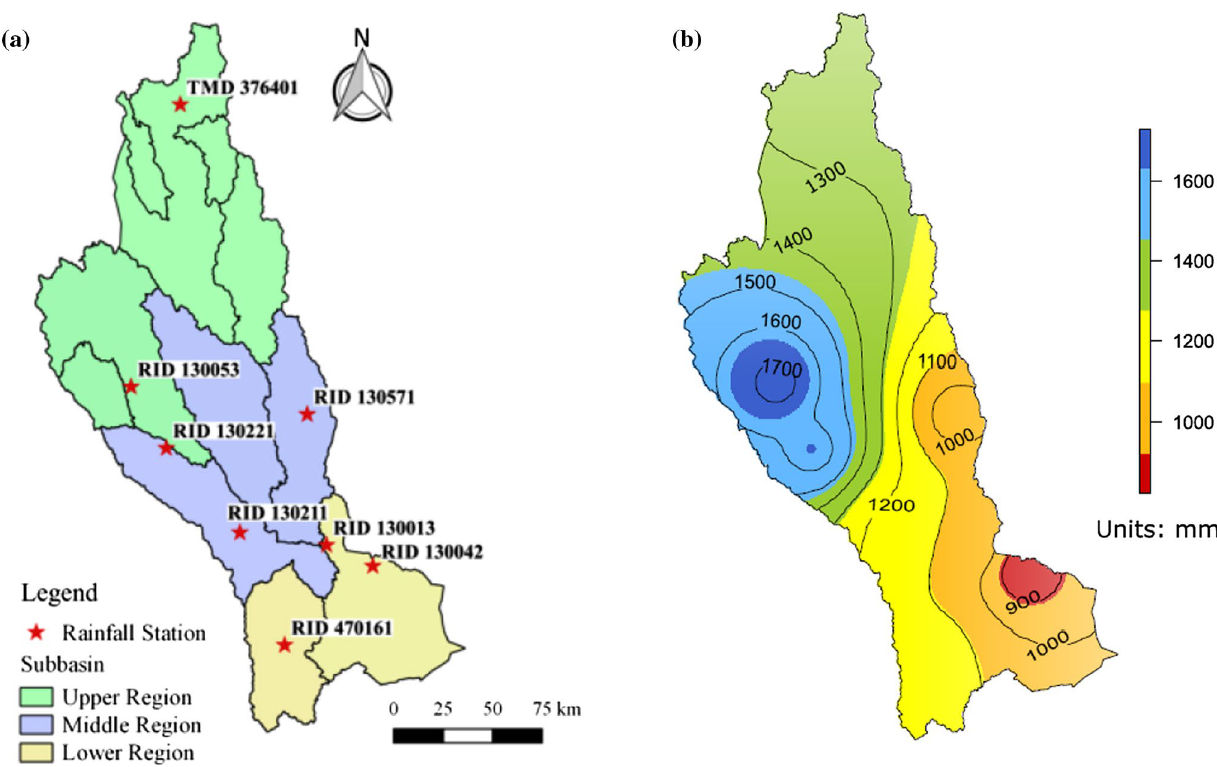
Fig. 2 Spatial distribution of a rainfall stations and b mean annual rainfall in millimeter for the period 1971–2015 in the Mae Klong River Basin ( adapted from Khalil 2020a; Khalil 2020b) Table 1 Rainfall stations with percentage of missing rainfall data during 1971–2015 Station code Station name Data available % of